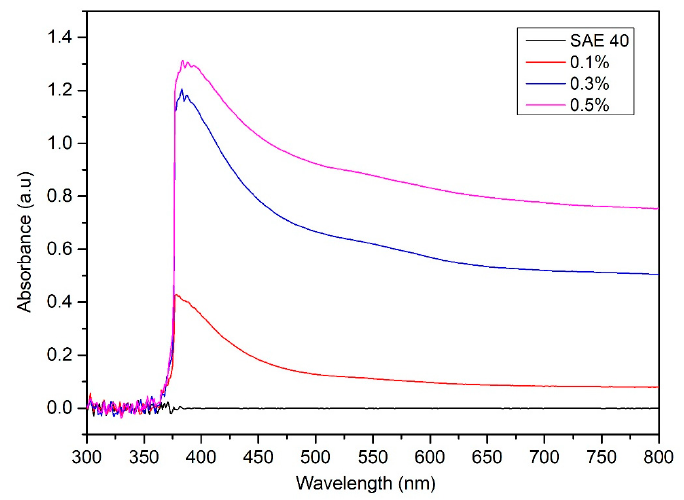
Figure 8. UV-Vis spectrum for a concentration from 0.1% to 0.5%.